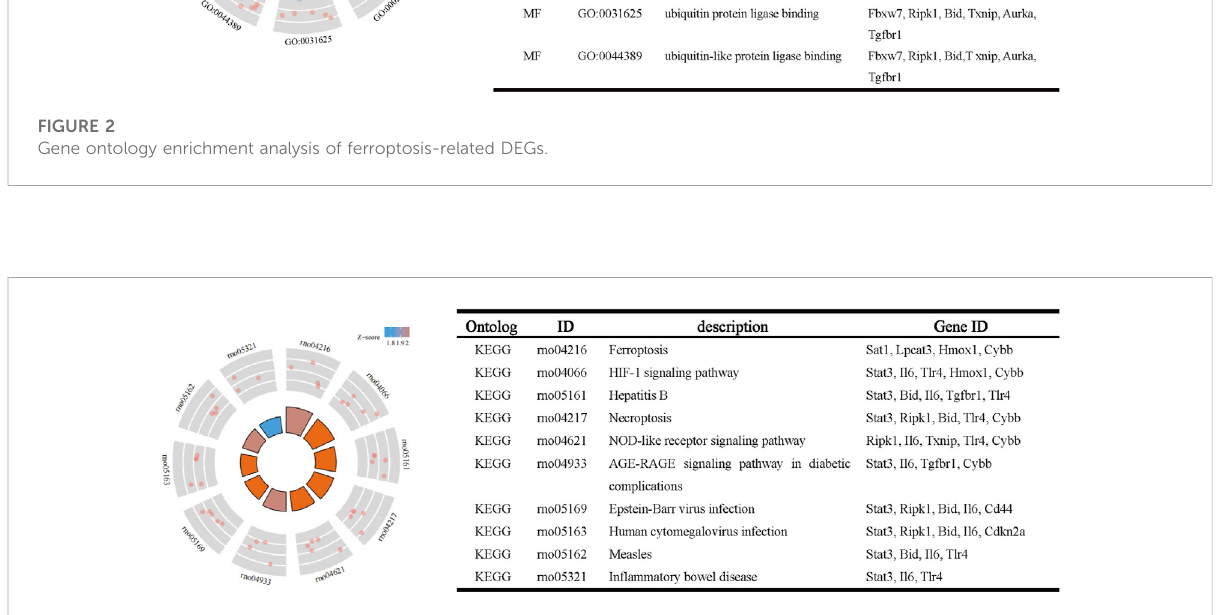
FIGURE 3 Kyoto Encyclopedia of Genes and Genomes pathway analysis of ferroptosis-related